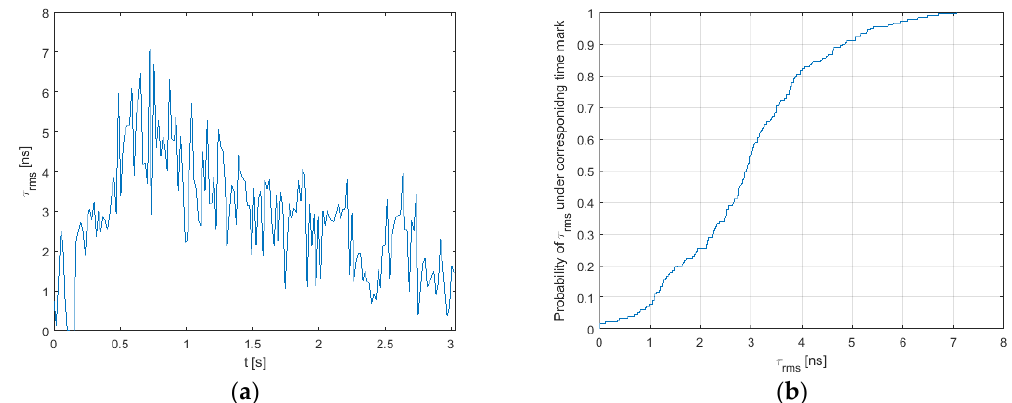
Figure 21. Measured PDPs shifted to align the main component.